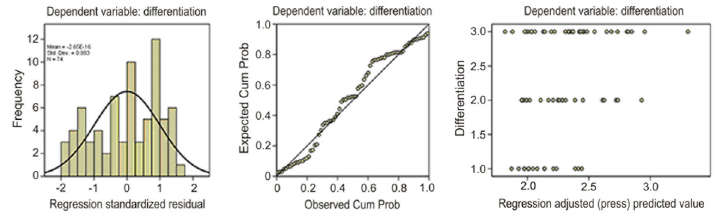
Figure 4. Multiple stepwise regression analysis of patients with non-small cell lung cancer